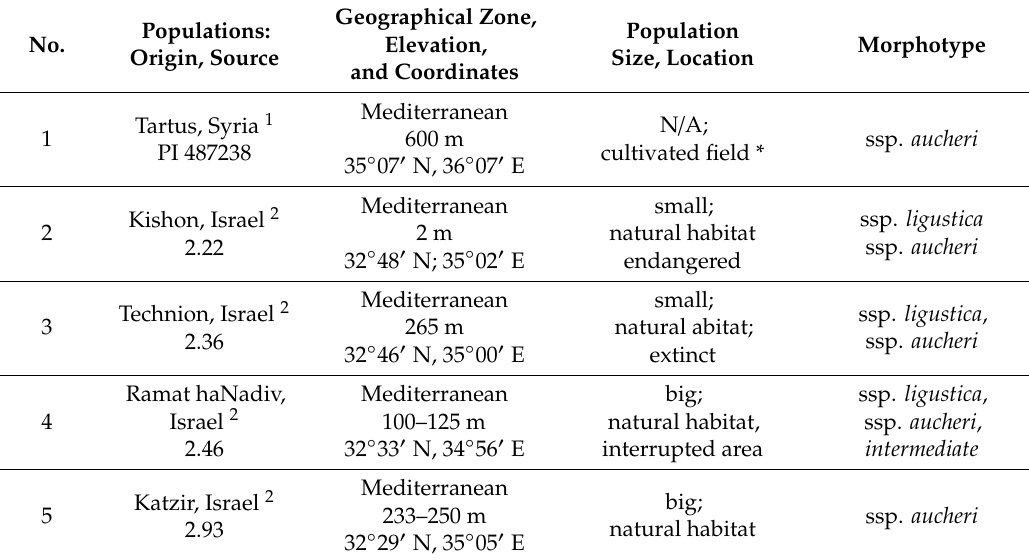
Table 1. Description of the populations of Ae. speltoides , the accession numbers and sources of plant